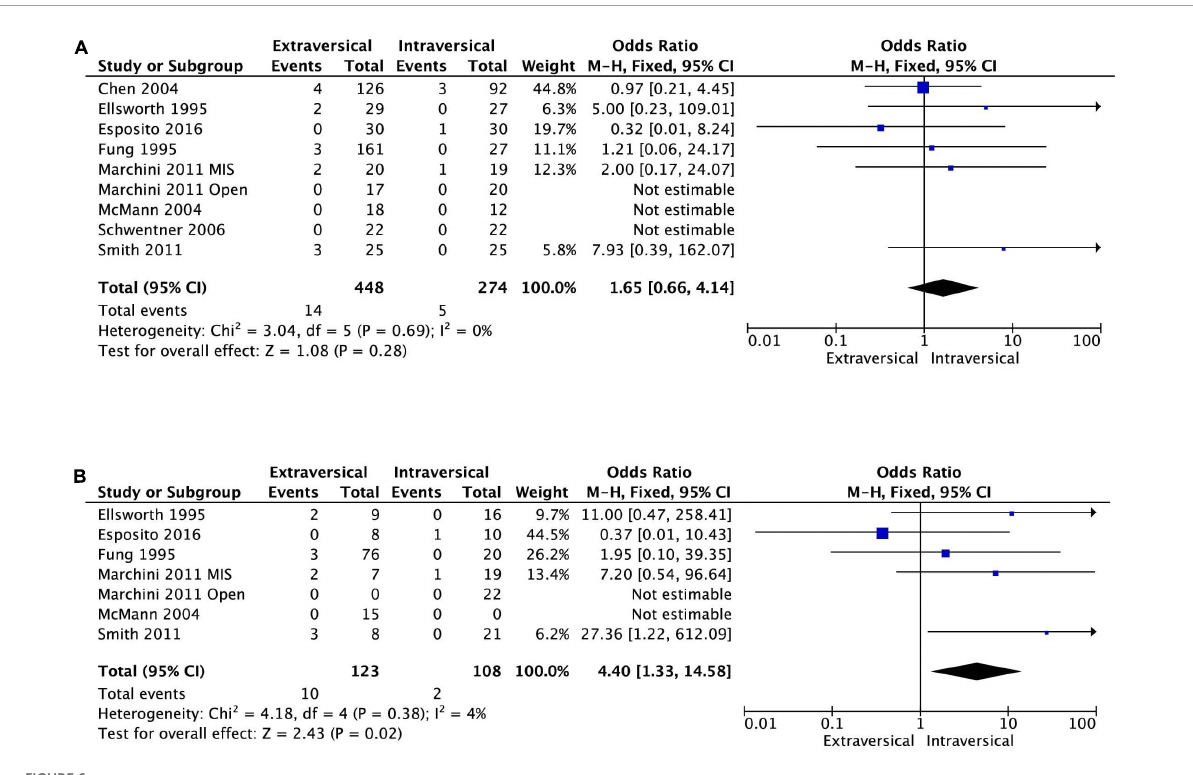
FIGURE6 Forest plot of acute retention of urine after EVUR vs. IVUR for VUR in general (A) and in bilateral VUR disease (B) .